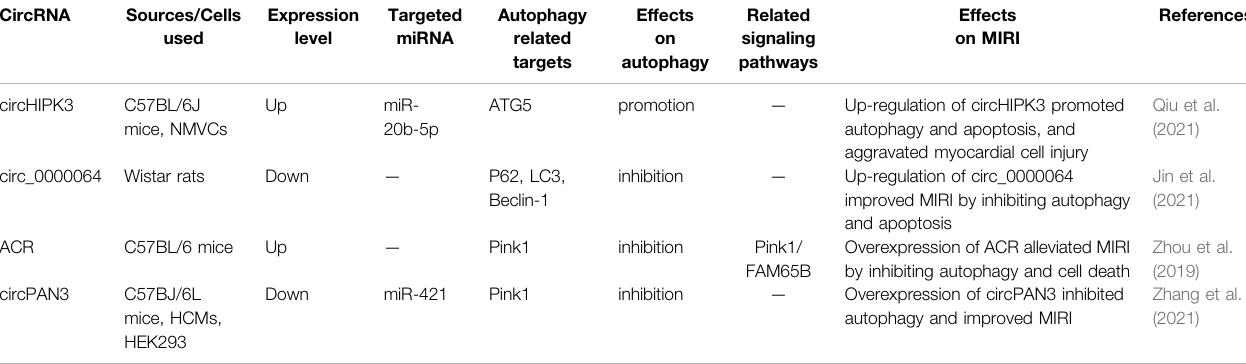
TABLE 3 | The regulatory role of circRNA in autophagy in the myocardial ischemia-reperfusion injury.